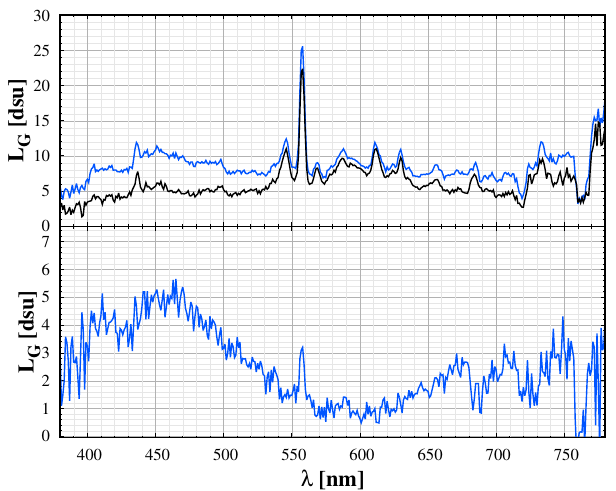
Figure 3. Top panel : the spectrum of the sky at a fixed location during astronomical night (black curve) and during twilight (blue curve). The lower panel displays the difference of the two above curves, the twilight component. Components of the natural sky spectrum used to fit the observations.